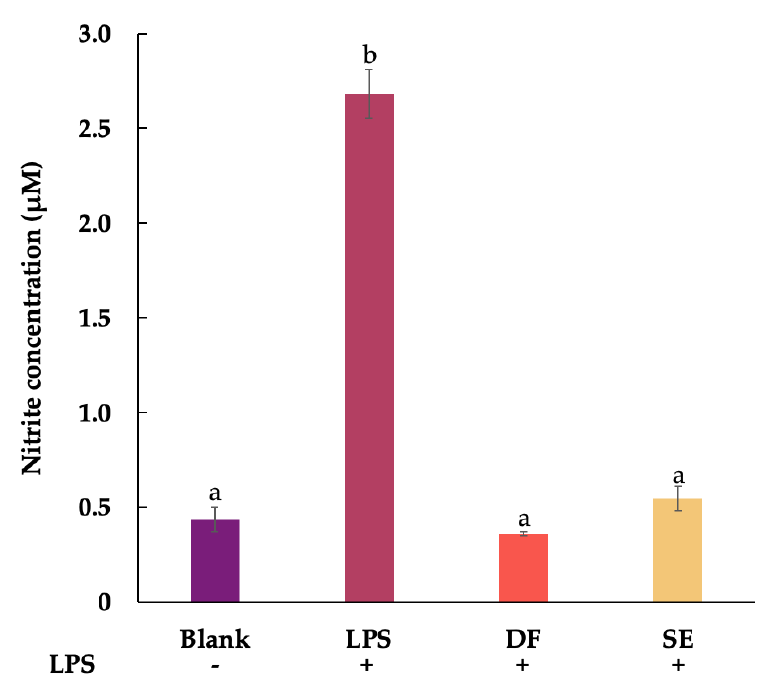
Figure 3. Effects of shallot extract (SE) and diclofenac sodium (DF) at the same concentration of 0.1 mg/mL on nitrite production in the lipopolysaccharide (LPS)-stimulated RAW 264.7 murine macrophages for 24 h compared to solvent-treated control without LPS (blank) and LPS-stimulated control (+LPS). Different letters (a and b) indicate statistical significance ( p < 0.05) in comparison to +LPS and DF.